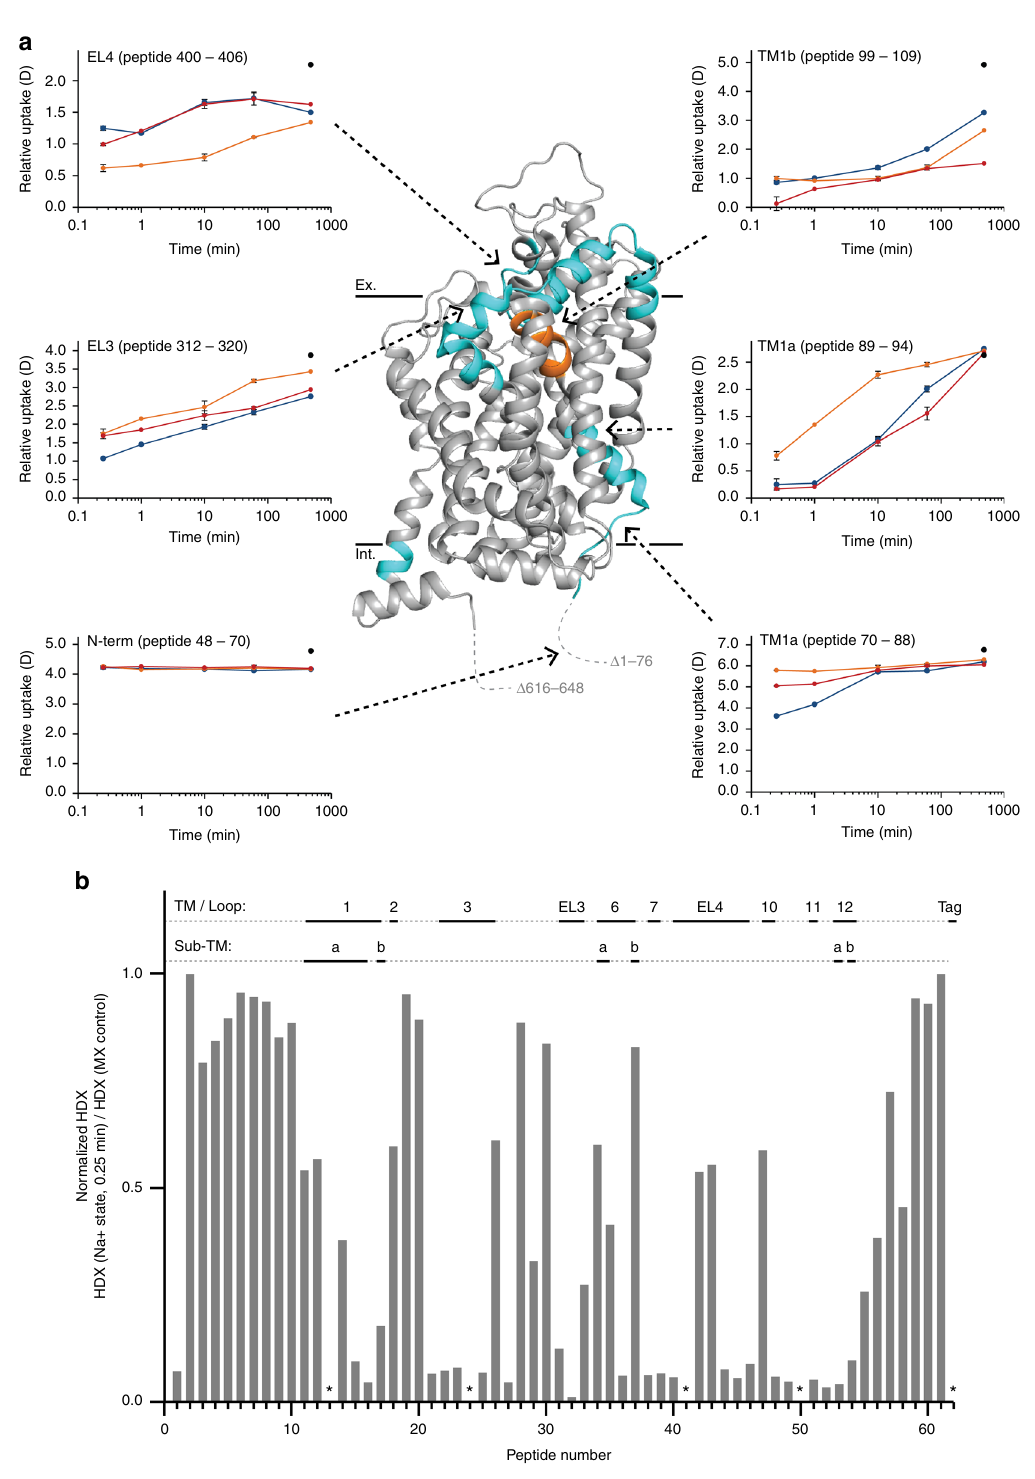
Fig. 1 Conformational dynamics of hSERT in solution. a The relative deuterium uptake of representative peptides is plotted as a function of labelling time (0.25 – 480 min) when hSERT was in the presence of Na + (blue), K + (orange), and Na + with 5-HT (red). Error bars indicate standard deviations for the 0.25, 10, and 60 min time points ( n = 2 – 4). Maximum labelled controls are indicated with a black dot. Peptides showing a difference in deuterium uptake between at least two states are coloured cyan on the crystal structure (PDB: 5i75). Orange indicates that EX1 kinetics was observed for at least one experimental state. Black solid lines at the top and bottom of the structural model show an approximation of the extracellular (Ex.) and intracellular (Int.) boundaries of the membrane, respectively. b The HDX of hSERT measured at the earliest time point (0.25 min) in the presence of Na + , normalized to the maximum labelled control sample, and plotted as a function of peptide number (Supplementary Table 1). Structural elements are indicated along the x -axis above the plot. (*) marks peptides where information was not available. Source data for the HDX data are provided as a Source data fi